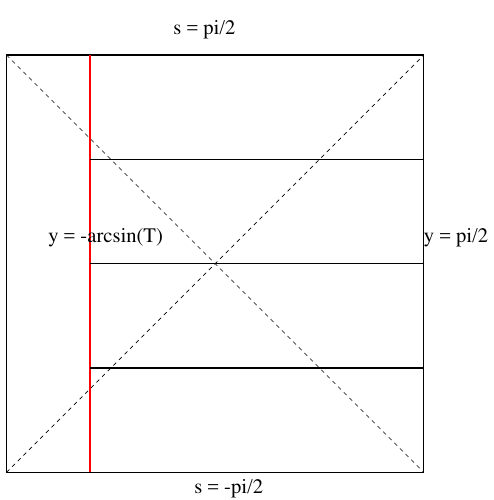
Figure 12 . BTZ black hole in s; y coordinates, showing ETW brane (red) and various geodesics orthogonal to it. Geometry to the left of the ETW brane is